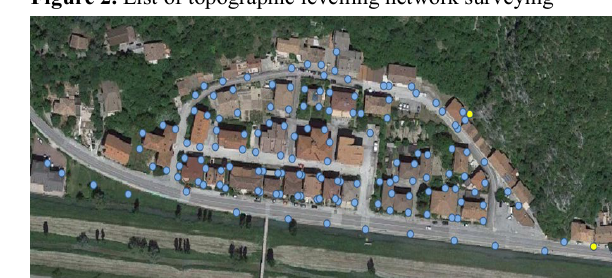
Figure 3. Targets of the topographic levelling network with identification of the two fixed markers (in